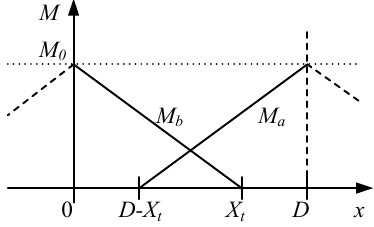
Figure 4. Mutual inductance profiles.